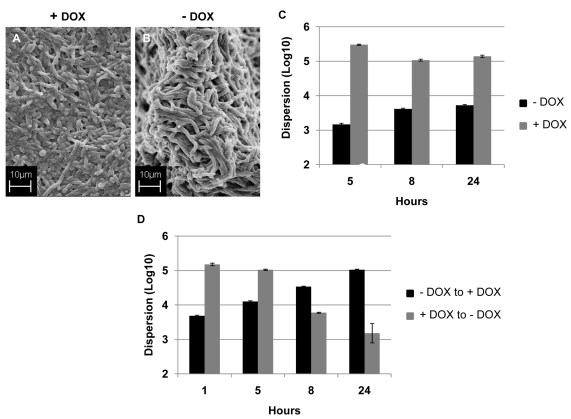
Regulation of C. albicans biofilm dispersion by UME6.Biofilms developed by the C. albicans tetO-UME6 strain in the presence (A) and absence (B) of DOX were imaged by SEM. Number of dispersed cells released from biofilms formed by the tetO-UME6 strain in the presence and absence of DOX were enumerated (C) and so was the impact of media switch from + DOX to - DOX and vice versa, on biofilm dispersion (D).